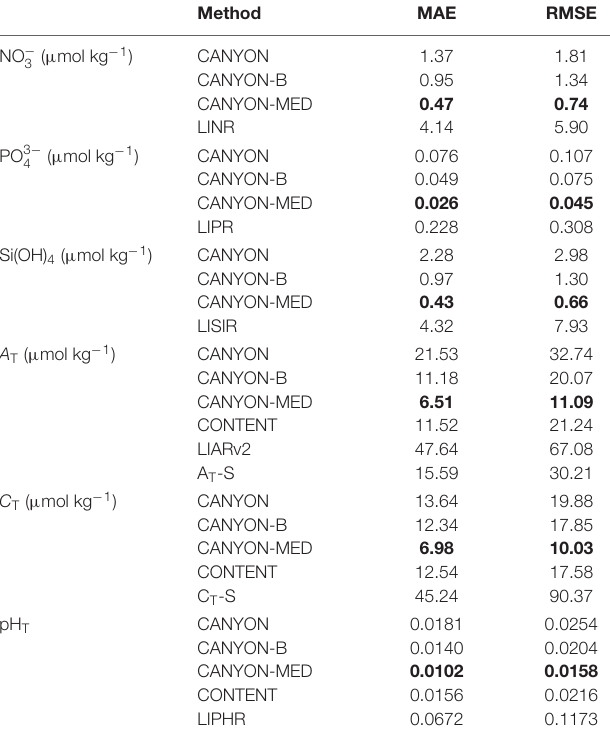
TABLE 5 | Performance indicators on the 20% validation dataset of CANYON (Sauzède et al., 2017), CANYON-B (Bittig et al., 2018), CANYON-MED (this paper), CONTENT (Bittig et al., 2018), A T -S and C T -S (Hassoun et al., 2015), LIARv2, LINR, and LIPHR (Carter et al., 2018) for NO − 3 , PO 3 − 4 , Si(OH) 4 , A T , C T , pH T